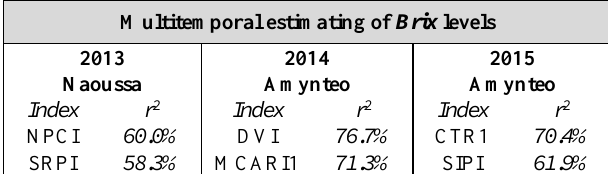
Table 2. The highest correlation rates regarding the estimation of Brix level for Syrah vineyards